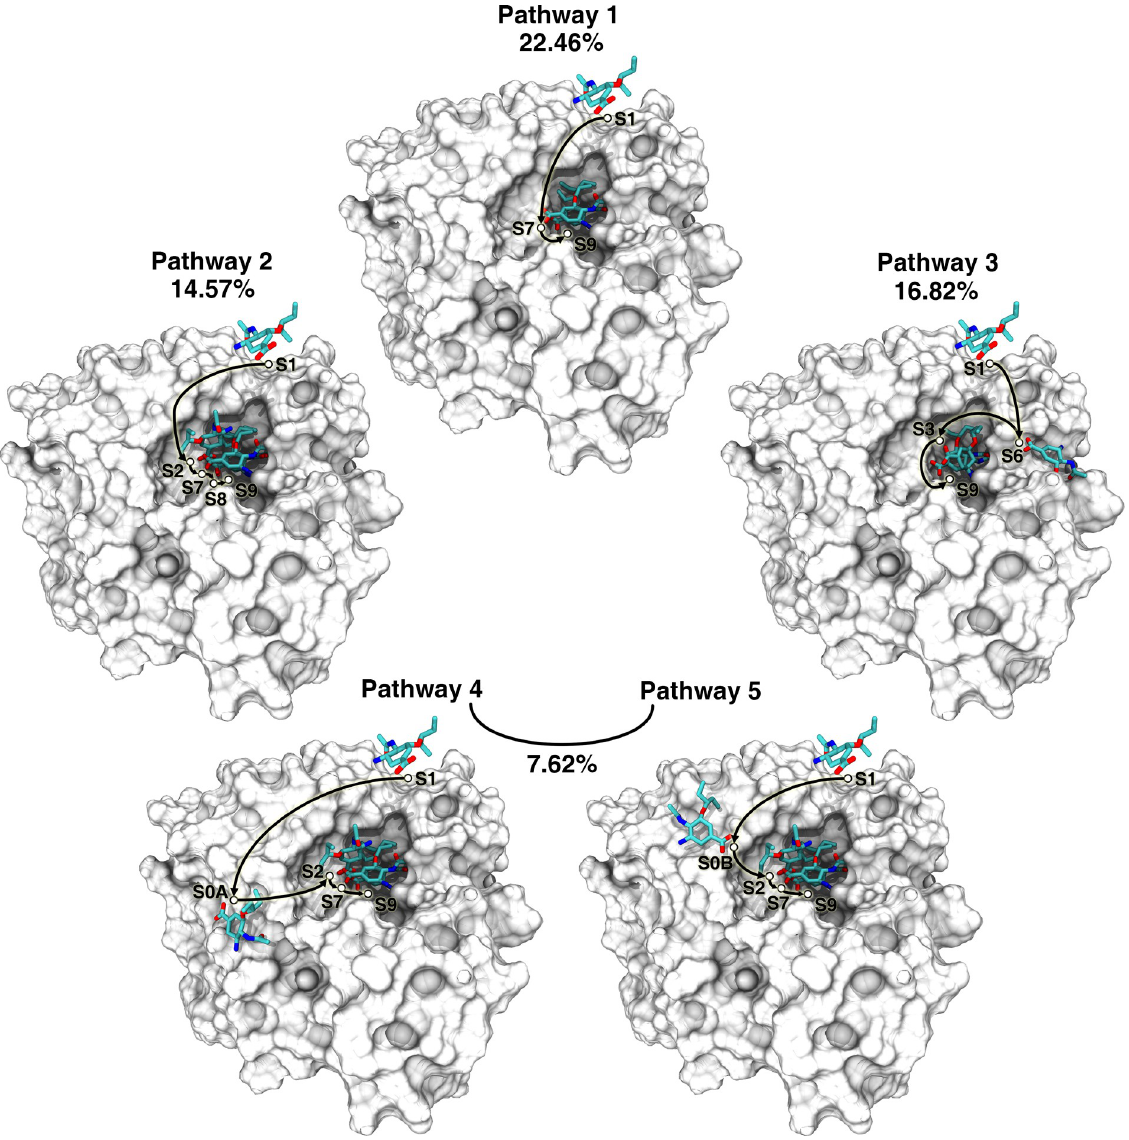
Fig 5. Transition modes for the metastable states in the main binding pathways. The circles refer to oseltamivir in the metastable states, and the arrows indicate transitions between the states. S1 and S9 are the start and end states of the binding process, respectively.